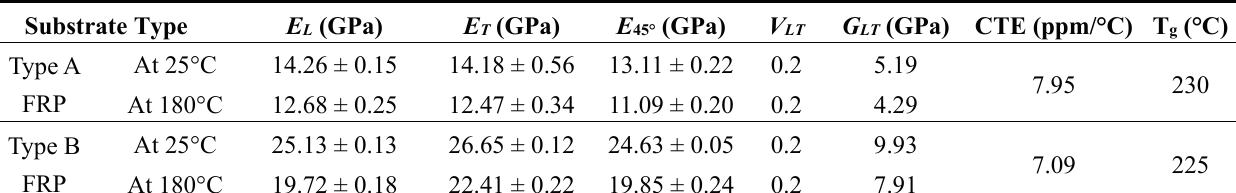
Table 1. Measured flexural moduli along the longitudinal, transversal and 45° directions, calculated shear moduli, coefficient of thermal expansion (CTE) and glass transition temperature of type A and B fiber-reinforced polymers (FRPs) at 25 and 180 °C. Poisson’s ratio and glass transition temperature were provided by manufacturer’s data table.